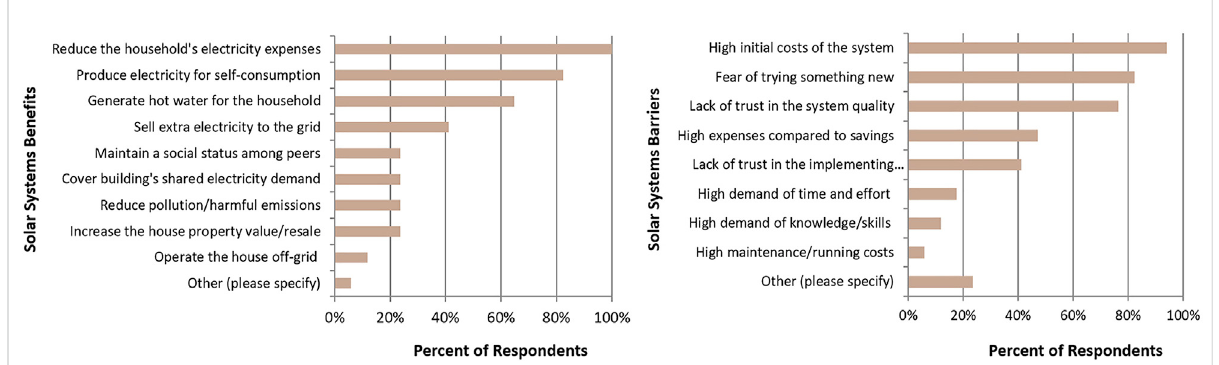
FIGURE 10 Results from the online survey showing the opinions of solar energy systems ’ experts and suppliers about the customers ’ perceptions of the main bene fi ts and barriers facing the systems ( n = 18 out of 20 total respondents). The respondents were asked to select the four most important